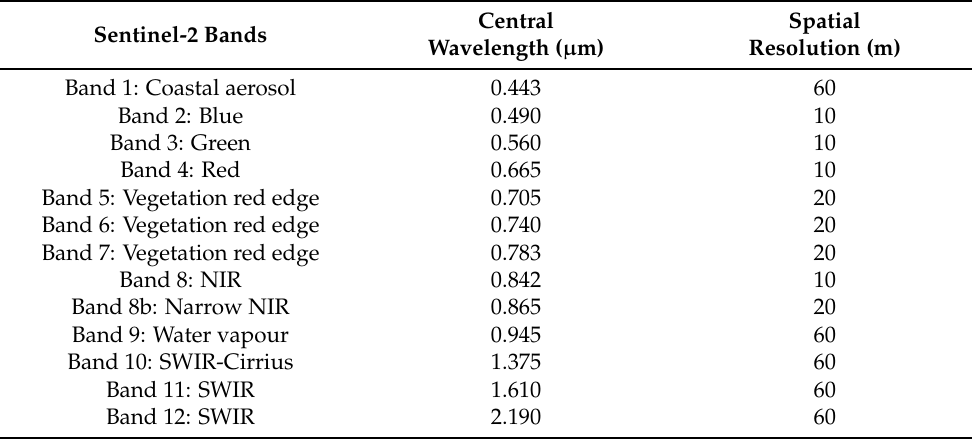
Table 3. Sentinel-2 band information